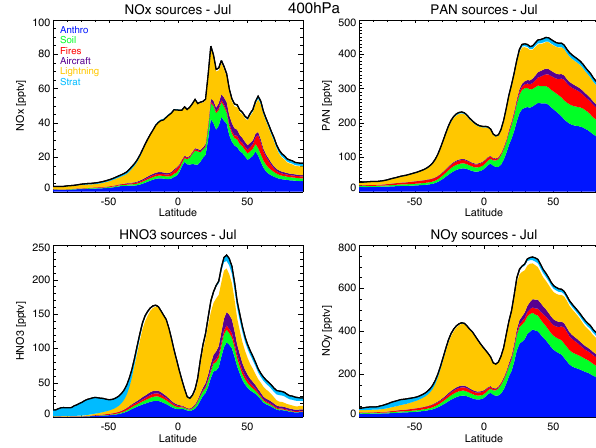
Fig. 7. As Fig. 6, for tagged NO x , PAN, HNO 3 and NO y source contributions at 400hPa in